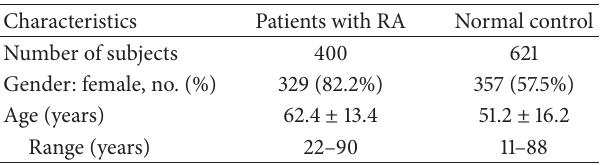
Table 1: Basal characteristics of patients with rheumatoid arthritis (RA) and of normal controls.